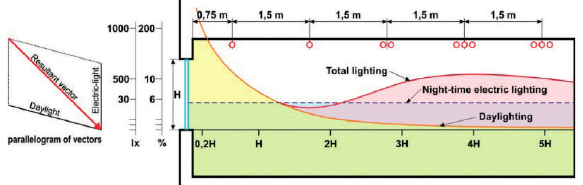
Fig. 5. Diagram of practical application of natural daylight and artificial light combination Source: Szokolay 2008.